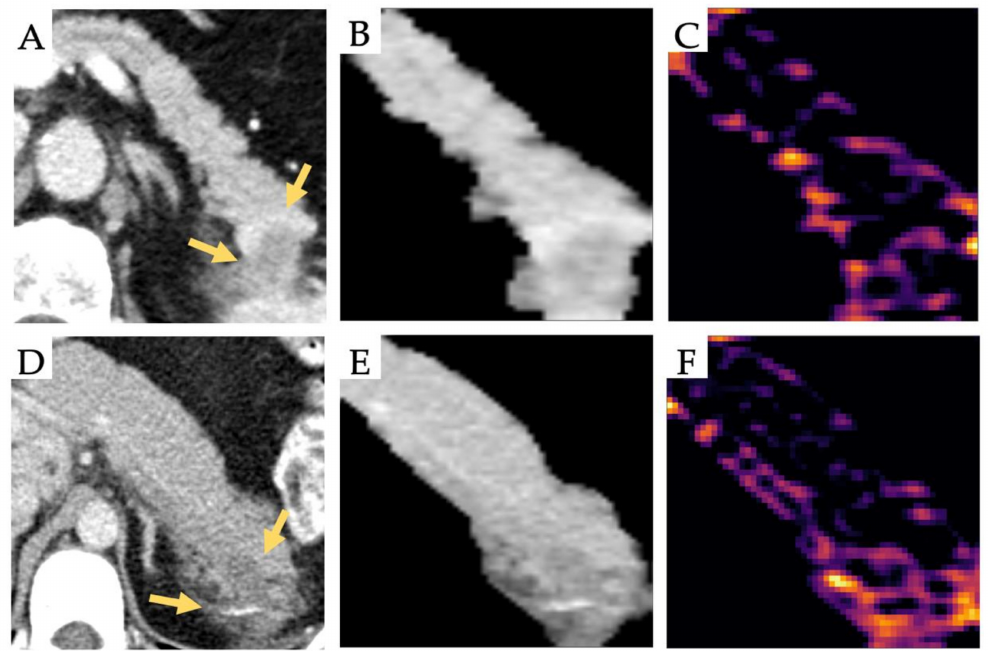
Figure 2. Representative CT-images (Yellow arrows pointing to the lesion) of a pancreatic ductal adenocarcinoma (PDAC) ( A ) and an autoimmune pancreatitis (AIP) ( D ) and their corresponding segmentation image ( B , E ) and feature map ( C , F ). For the AIP lesion, the activation of the feature map appears to focus on the internal structure; in contrast, activation is noted at the transition zone between the lesion and normal tissue for the